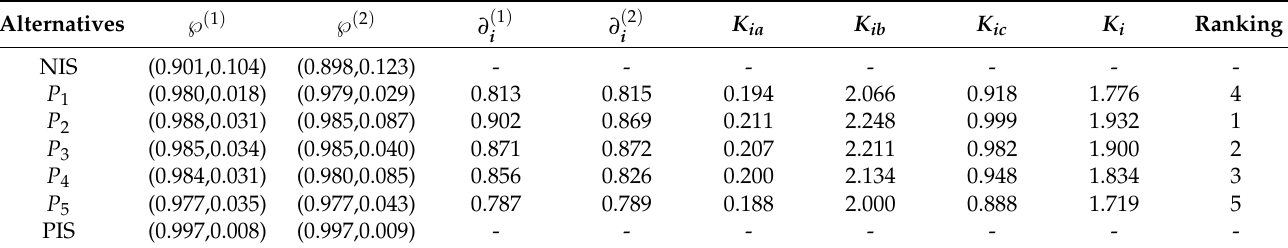
Table 8. The aggregation strategies and final sorting result of